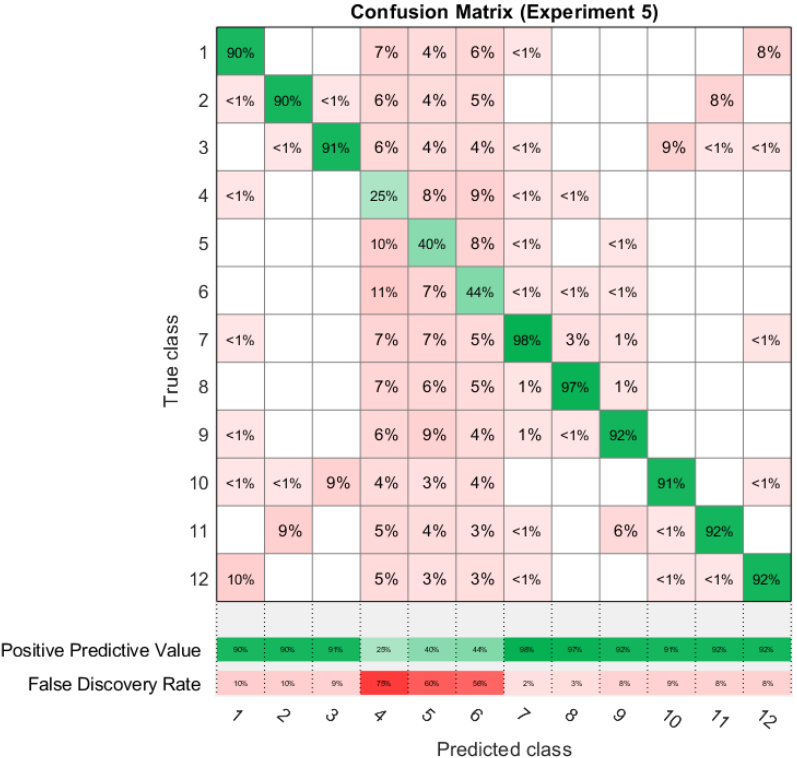
Figure 18. Data set of experiment 5.